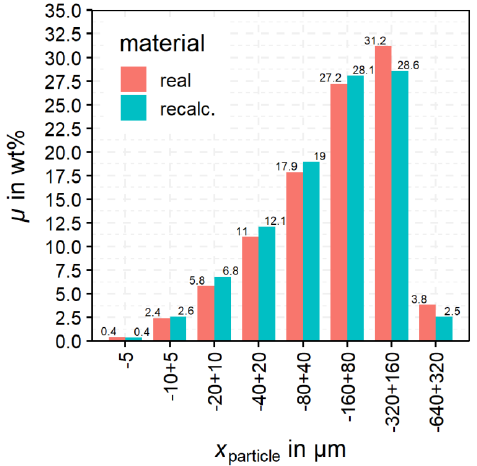
Figure 3. Comparison of mass fractions in different particle size classes for the real feed (real) and recalculated feed (recalc.). The latter is recalculated from the MLA-data of the three products of magnetic separation.